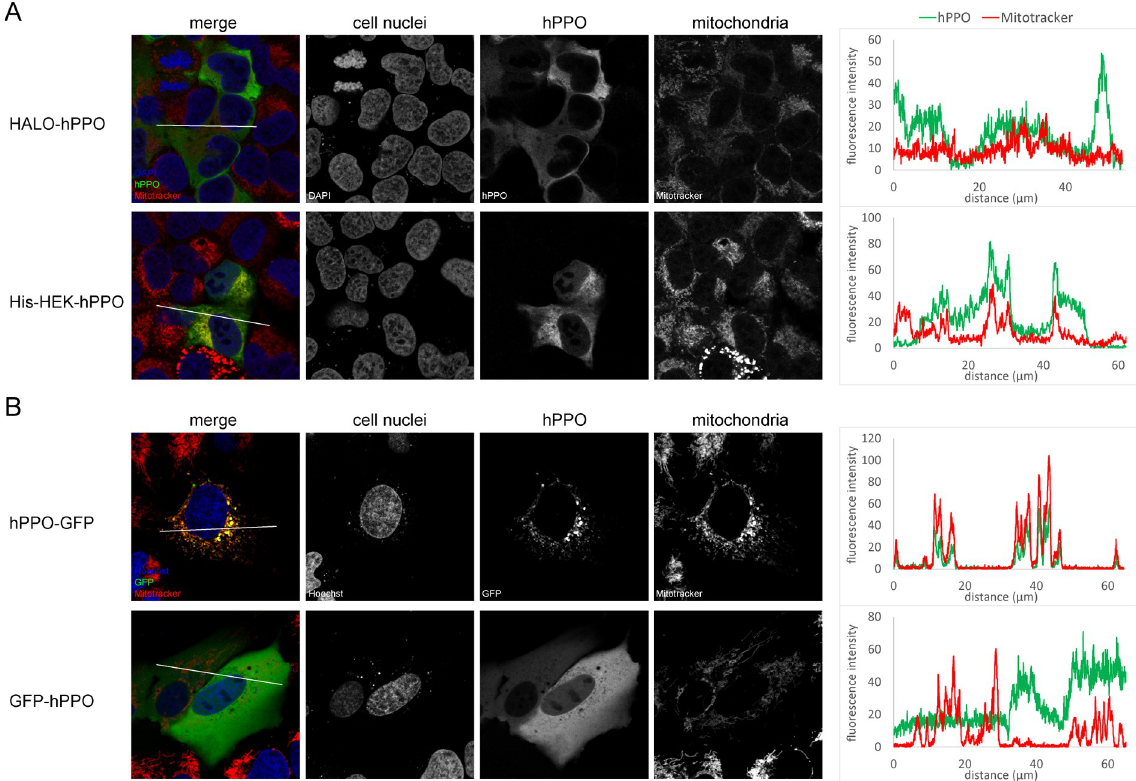
Fig 5. Localization of hPPO constructs in cell. A; hPPO variants were transfected into in U-2 OS cells and visualized using PPOX-specific antibody (green channel) with a confocal microscope. Mitochondria were stained by Mitotracker Deep Red FM dye (red channel), whereas cell nuclei were visualized by DAPI staining (blue channel). B; Localization of GFP-tagged constructs was detected in live cells by a confocal microscope (green channel). Mitochondria were visualized by Mitotracker Deep Red FM (red channel), whereas cell nuclei were stained by Hoechst 33258 (blue channel). Charts on the right side show the colocalization of hPPO constructs and mitochondria marker Mitotracker in the area marked by a white line.